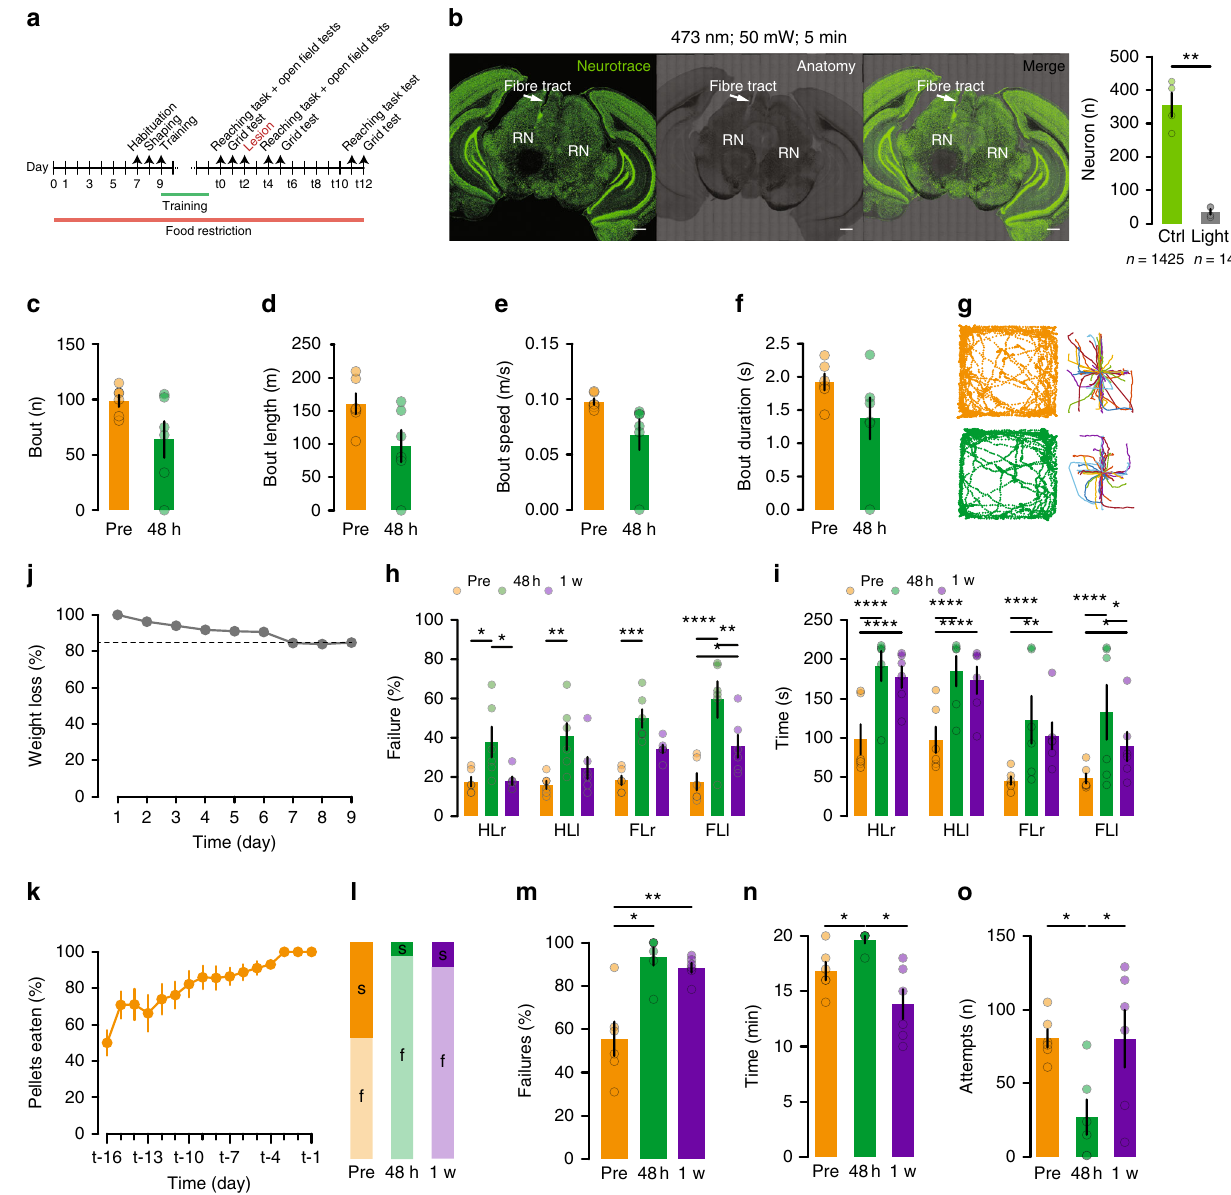
Fig. 1 RN ablation impairs reaching and grasping, sparing locomotion. a Experimental design. b Neurotrace staining and lesion protocol validation and quanti fi cation t (3) = 8.36, P = 0.0036, n = 4 mice (Scale bar, 500 µ m). c Number, d length, e speed and f duration of bouts during locomotion in the OFT ( n = 6 mice). g Example track plots and bout decomposition. h Failure for each limb in the EGT, 2WRM-ANOVA F (2,40) = 36.21, P < 0.0001 (HL: hindlimb, FL: forelimb, r: right, l: left). i Completion time, 2WRM-ANOVA F (2,40) = 23.81, P < 0.0001. j Weight loss stabilization at 85% body weight during the food restriction period. k Learning curve as pellets consumed in the SPRT. l Distribution of success and failure across the 3-time points. m Failure rate, 1WRM- ANOVA F (1.3,6.5) = 17.83, P = 0.0035. n Completion time, 1WRM-ANOVA F (1.2,5.9) = 8.43, P = 0.0251. o Number of attempts, 1WRM-ANOVA F (1.6,7.8) = 8.79, P = 0.0127. All data are reported as mean and SEM. Pre-lesion performance are depicted in orange (Pre), performance 48 h after lesion are shown in green and performance a week after lesion (1 w) are displayed in purple Vglut2- cells co-express PV and C1QL2 . We took a step towards against C1QL2, a complement protein that has previously been reported as a speci fi c marker for RN neurons 33 (Fig. 3c, d, Sup- characterizing the genetic identity of neurons in the RN and fl uorescent in-situ hybridization (FISH) revealed a rather mini- plementary Fig. 2). Finally, we con fi rmed the above result with a triple co-localization FISH assay that demonstrated the abundant mal presence of inhibitory Vgat-positive cells along with a pre- presence of Vglut2, PV and C1QL2 in the RN region (Fig. 3e, f). dominant population of excitatory Vglut2-positive cells that interestingly, co-express the calcium-binding protein parvalbu- min (PV) to a large extent (Fig. 3a, b). This fi nding adds to an exciting and emerging research fi eld reporting the presence of PV Vglut2- cells exhibit speci fi c intrinsic properties . Following the in excitatory neurons in sub-cortical areas 32 . This pattern was FISH evidence suggesting that the excitatory Vglut2-positive also observed when probing the expression of Vgat and Vglut2 cells are the main population in the RN, we performed in vitro NATURE COMMUNICATIONS| (2019) 10:2241